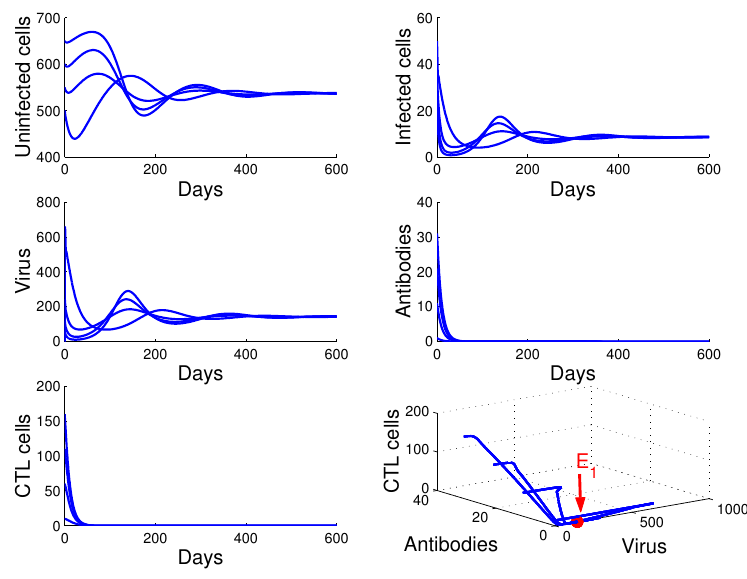
Figure 1. Demonstration of the global stability of the infection-free equilibrium E 0 for R 0 = 0.9751 ≤ 1.